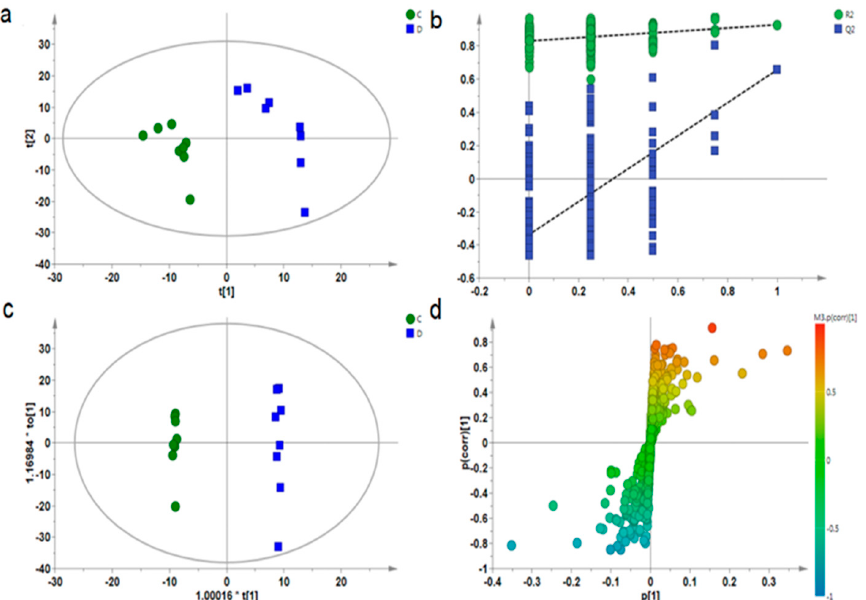
Figure 5. PLS-DA diagram ( a ), PLS-DA model verification diagram ( b ), OPLS-DA diagram ( c ), and corresponding S-plot diagram ( d ) for the soleus muscle samples of groups C and D.